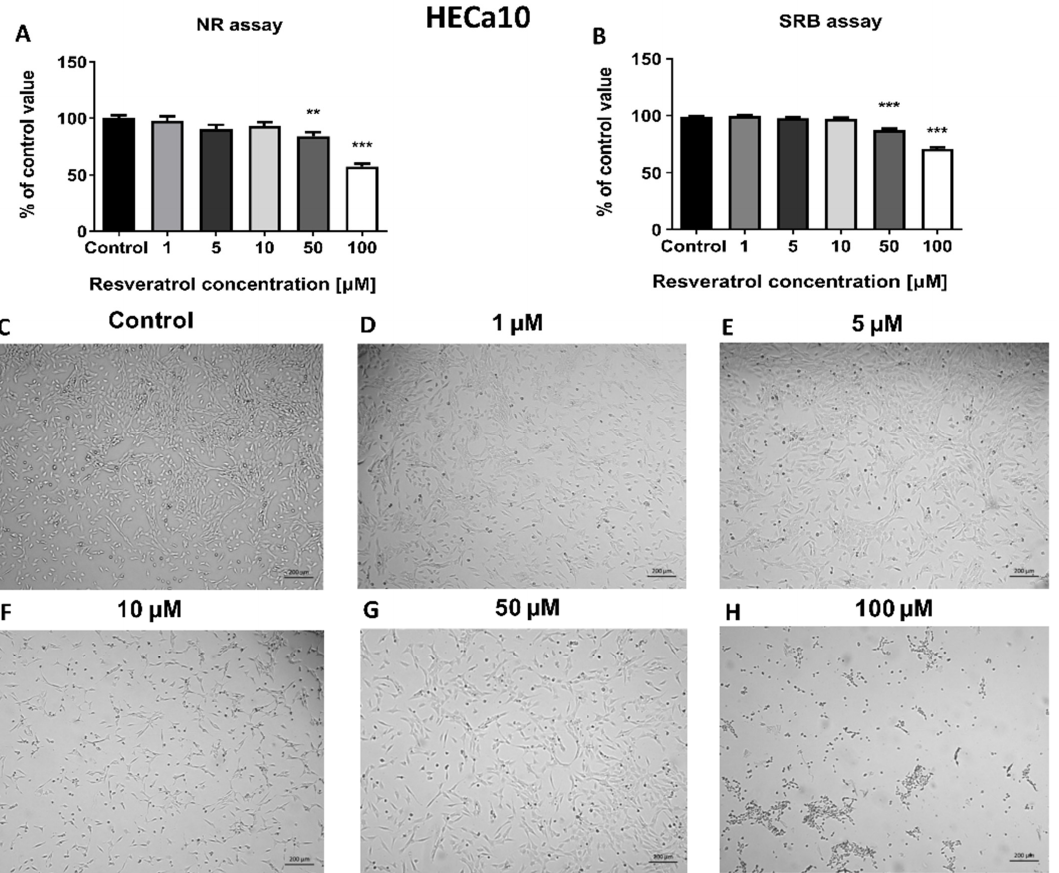
Figure 1. Effect of different RSV concentrations on HECa10 cell proliferation as analysed by ( A ) NR assay and ( B ) SRB assay. Cell were incubated for 24 h with RSV (1, 5, 10, 50, and 100 µM). Control cells were cultured with 0.1% DMSO and without RSV. ( C – H ) Light microscopy images of control and RSV-treated cells (Delta Optical, magnification 100×). The results are presented as mean ± SD at least of three experiments with ** p < 0.01, *** p < 0.001 compared to control.